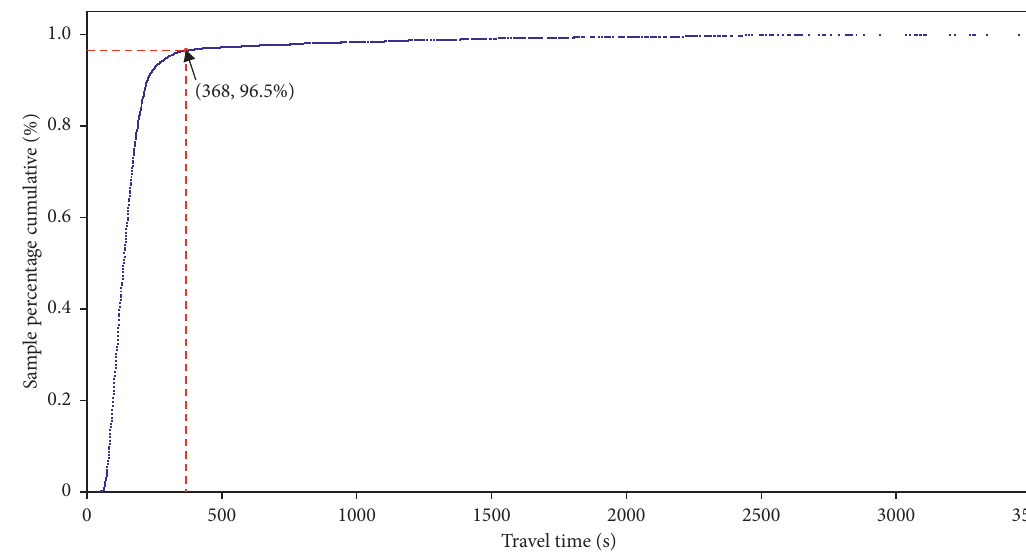
Figure 11: Probability cumulative curve of road travel